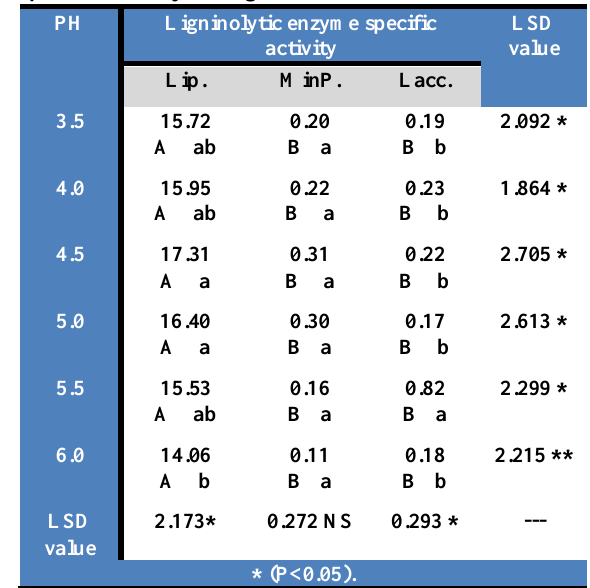
Table, 10: Effect of PH and enzymes production in specific activity